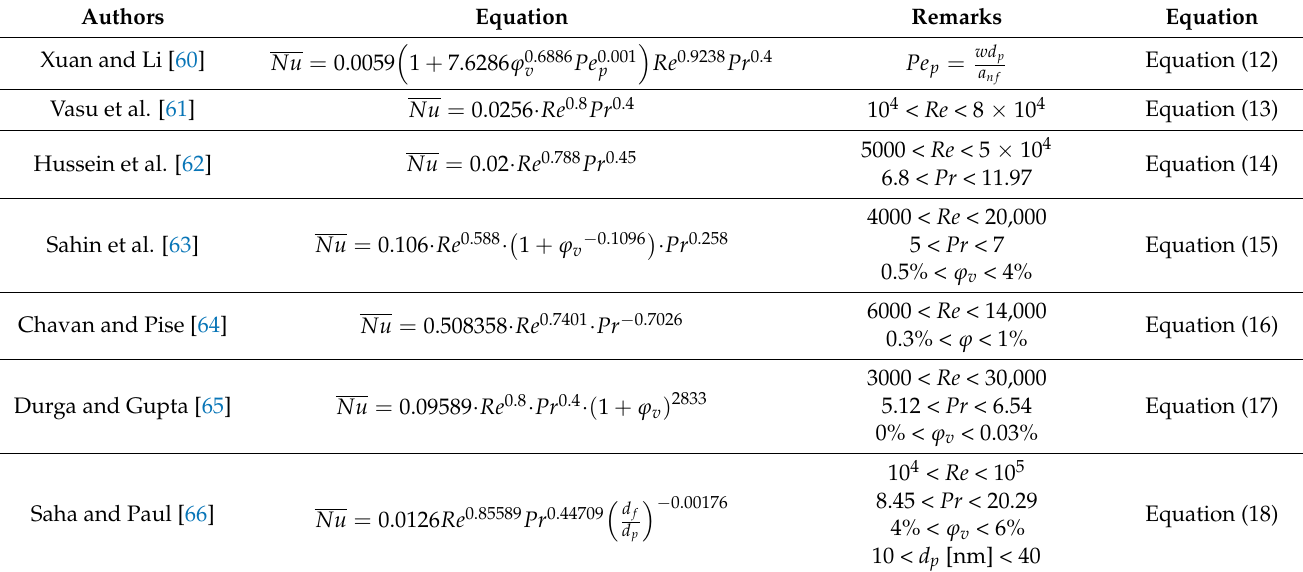
Table 3. Nu number correlation equations for water- Al 2 O 3 nanofluids.